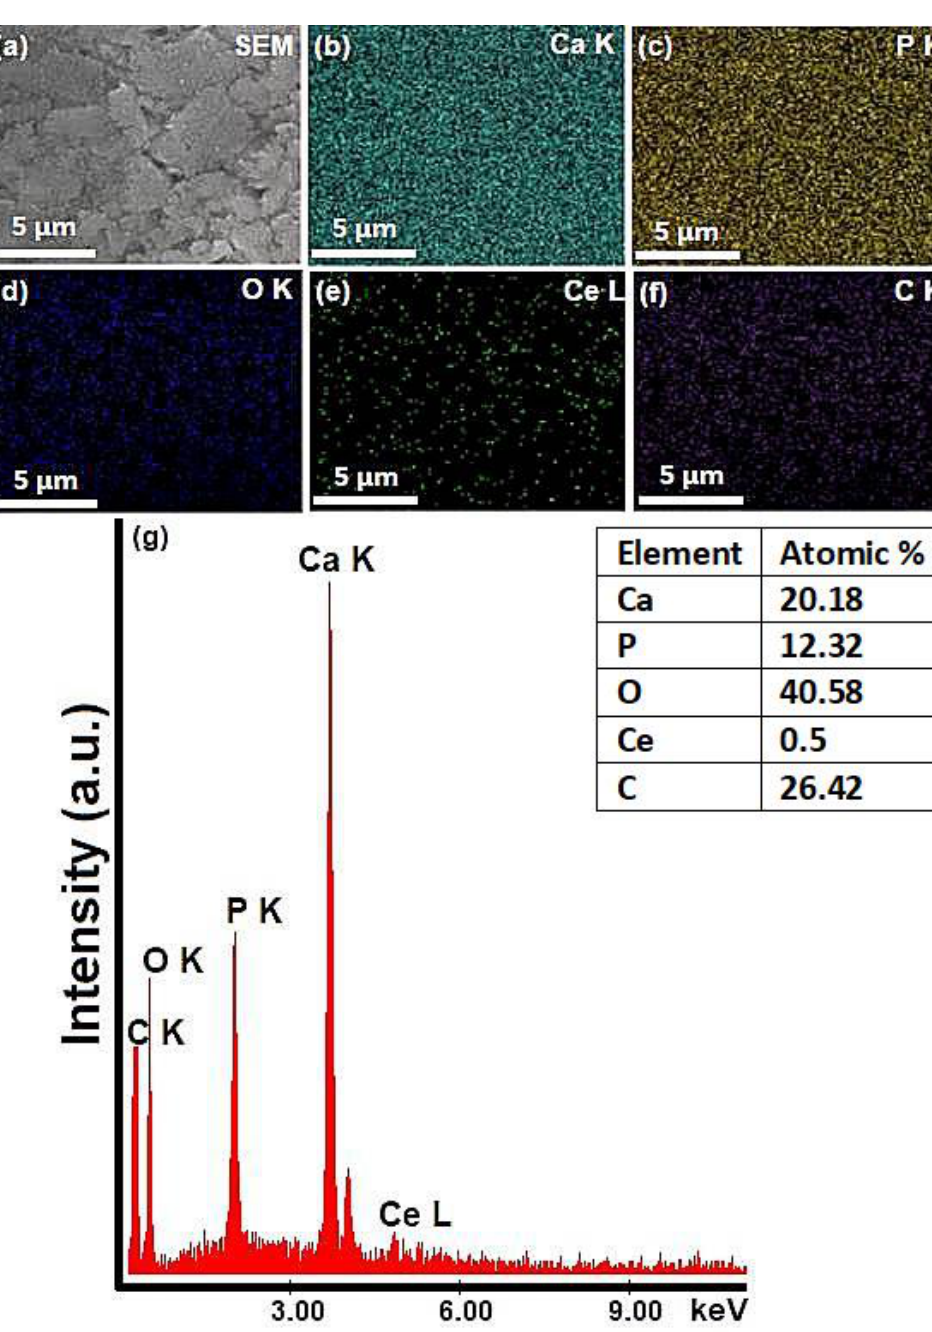
Figure 3. SEM image ( a ), EDS elemental mapping of the constituent elements of 5CeHAp-D composite target ( b – f ) and EDS spectrum of 5CeHAp-D composite target ( g ).